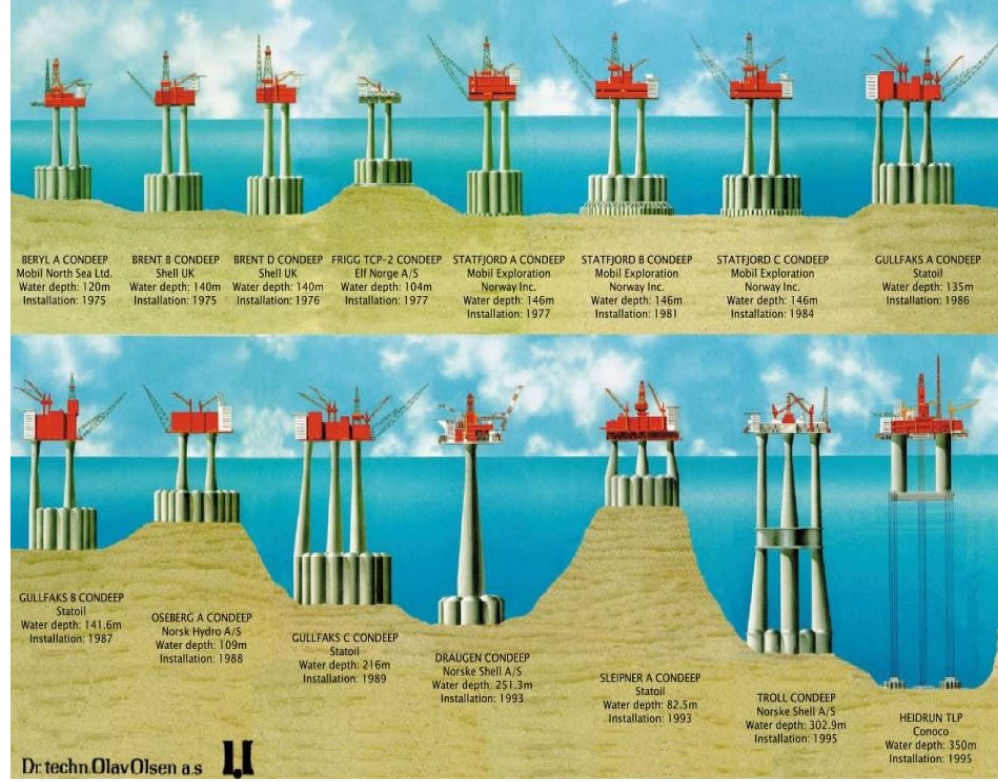
Figure A5. Different Condeep concepts of gravity based structures in the North Sea (Courtesy: Dr.techn, OlavOlsen